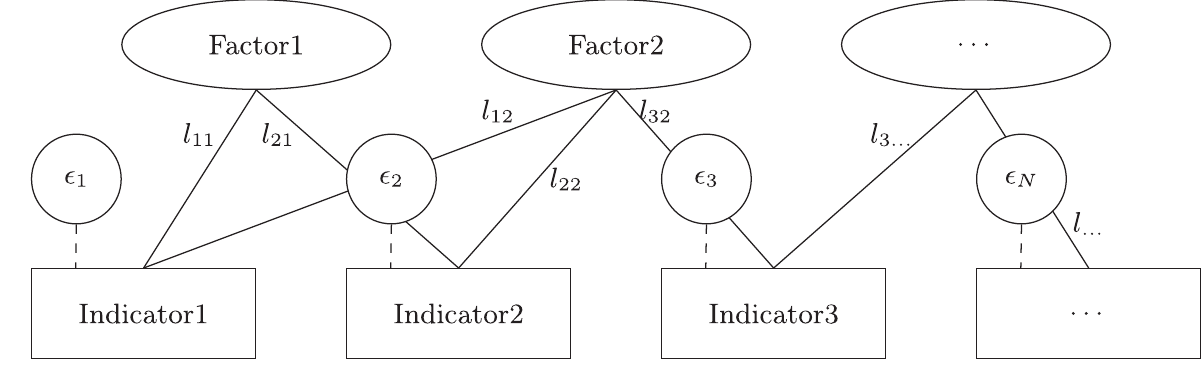
Figure 1. Concept of factor analysis with loadings l ij and unique variances (cid:2) i